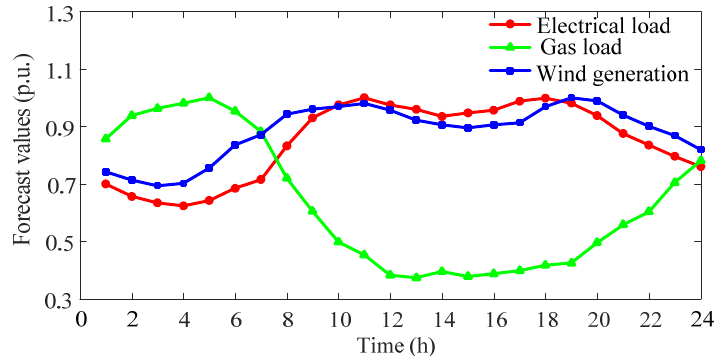
Figure 2. Structure of integrated power and gas systems.